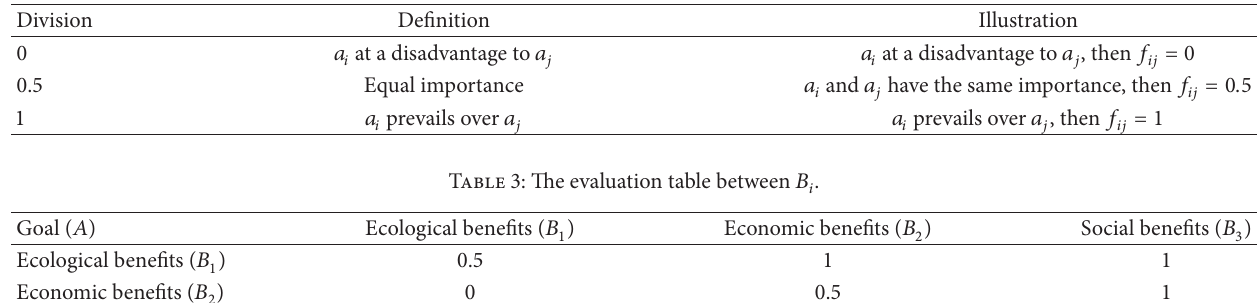
Table 2: Overview of the three-scale division.